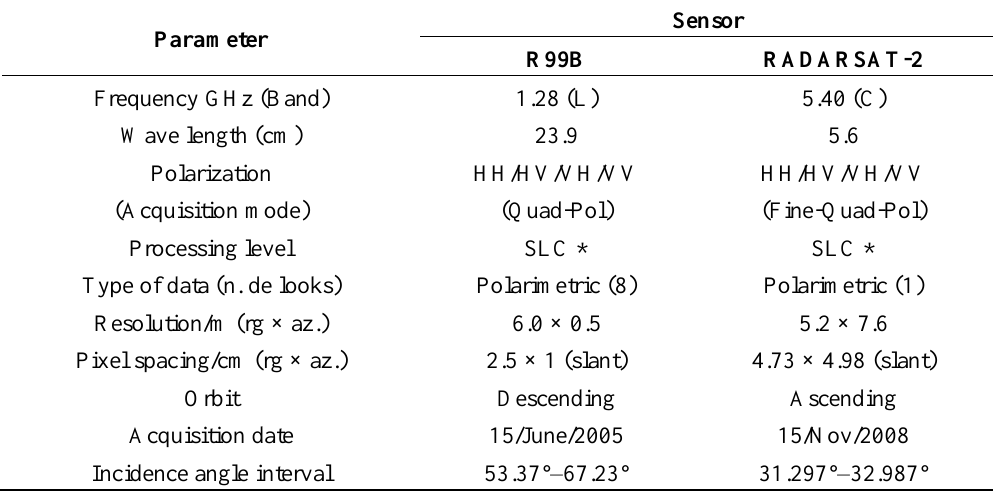
Table 1. Characteristics of the SAR images acquired by the R99B and RADARSAT-2